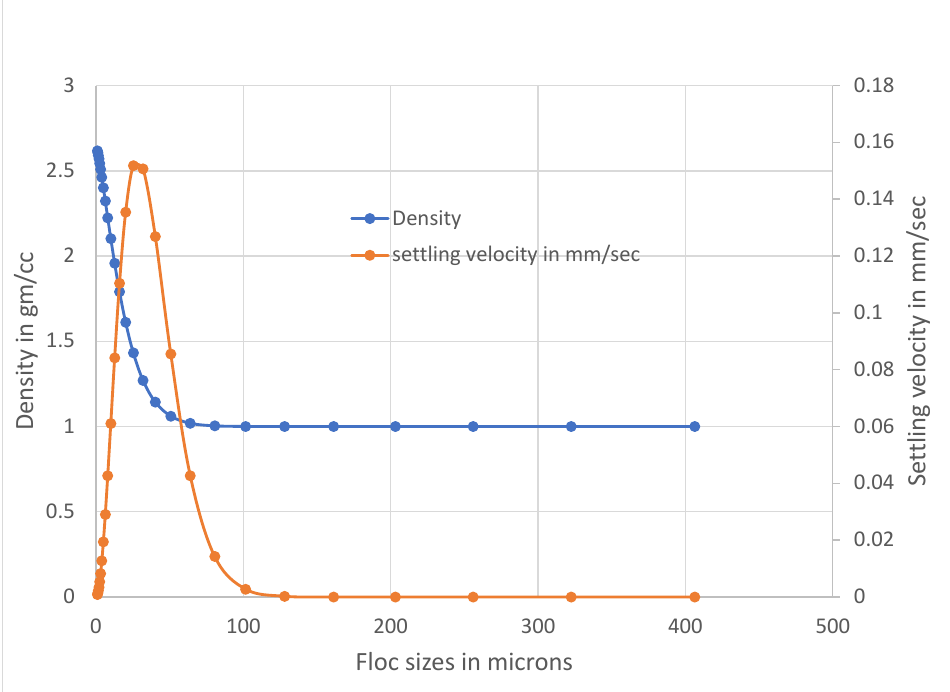
Figure 9. Density and settling velocity of sediment flocs as a function of floc sizes for suspended sediment in the Crowsnest River.